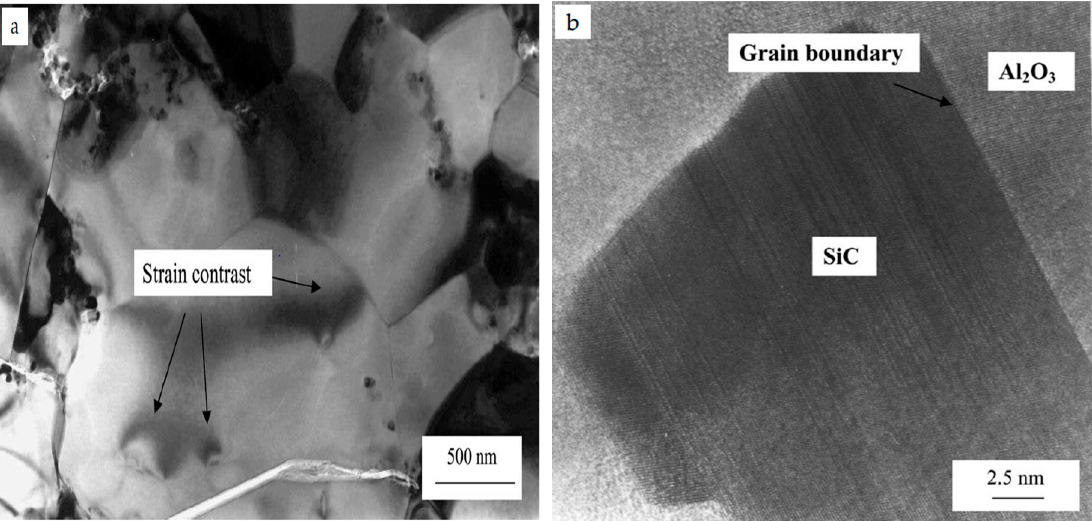
Figure 5. High-resolution transmission electron microscope (HRTEM) micrographs of Al 2 O 3 -5SiC nanocomposites: ( a ) distribution of SiC particles; ( b ) phase boundary between SiC and alumina. Reproduced with permission from [94]. Copyright Springer Nature, 2002.